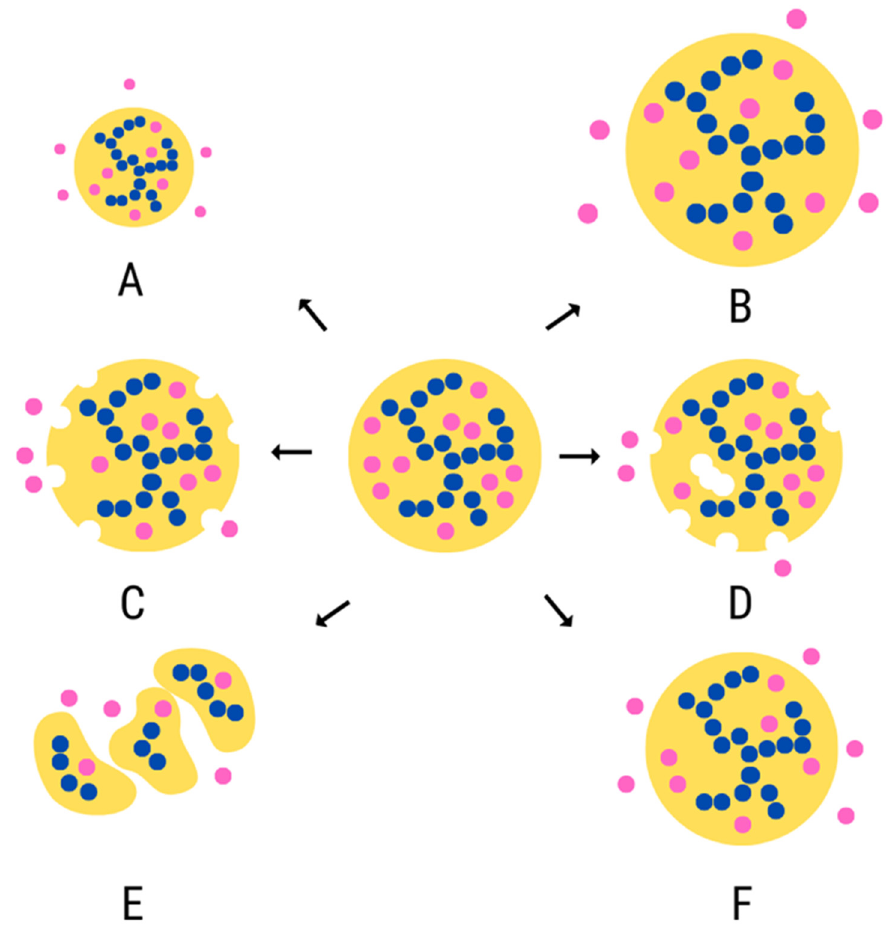
Figure 4. Various types of release mechanisms for EO-encapsulated component: shrinkage ( A ), swelling ( B ), surface erosion ( C ), bulk erosion ( D ), fragmentation ( E ), diffusion ( F ), own elaboration [106] .